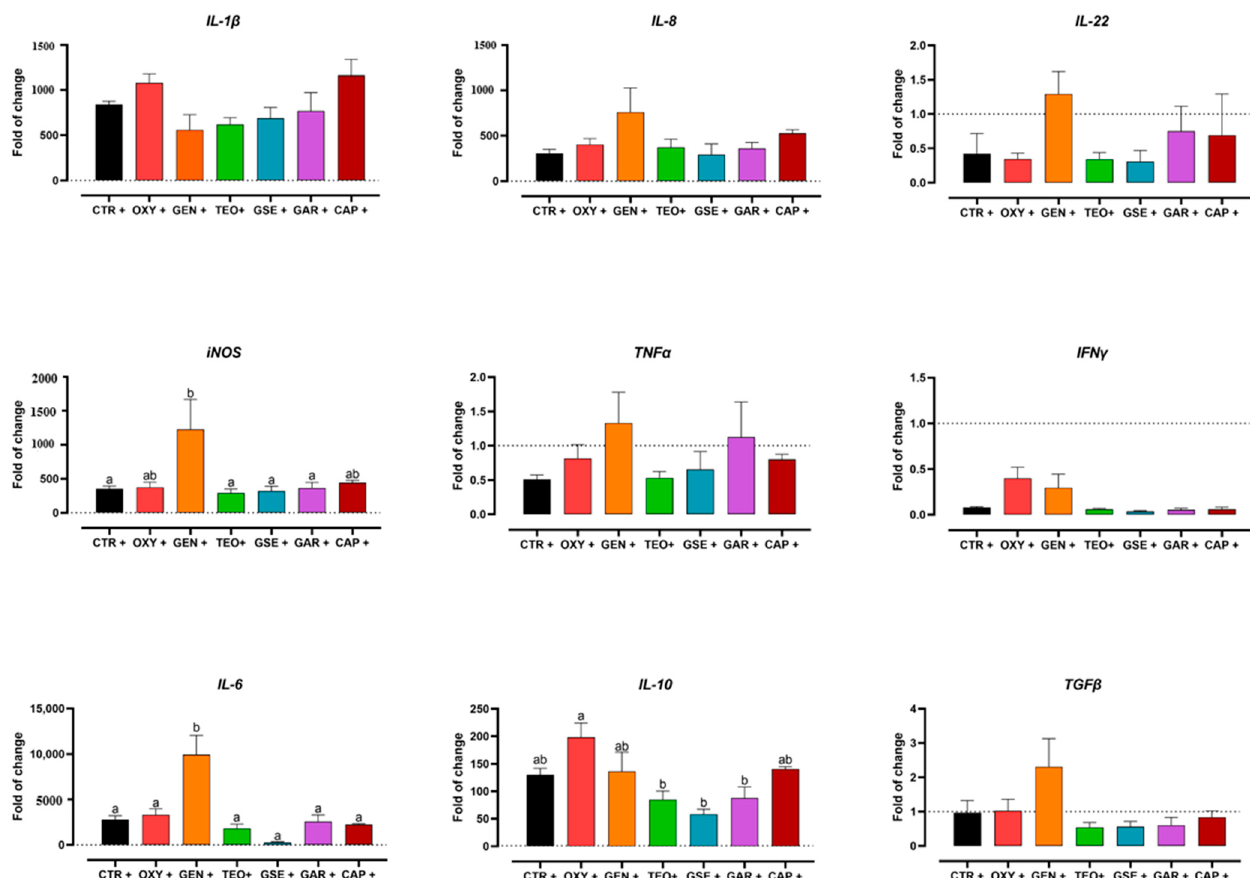
Figure 6. mRNA expression of IL-1 β , IL-8 , IL-22 , iNOS , TNF α , IFN γ , IL-6 , IL-10 , and TGF β of HD11 cells infected with S. Enteritidis and treated with antibiotics (oxytetracycline (OXY), gentamicin (GEN)) or plant extracts (thyme essential oil (TEO), grape seed extract (GSE), garlic oil (GAR), capsicum oleoresin (CAP)). Dashed lines represent the CTR—threshold, set as 1. Data are presented as mean ± SEM. Different letters indicate statistical significance with p < 0.05.